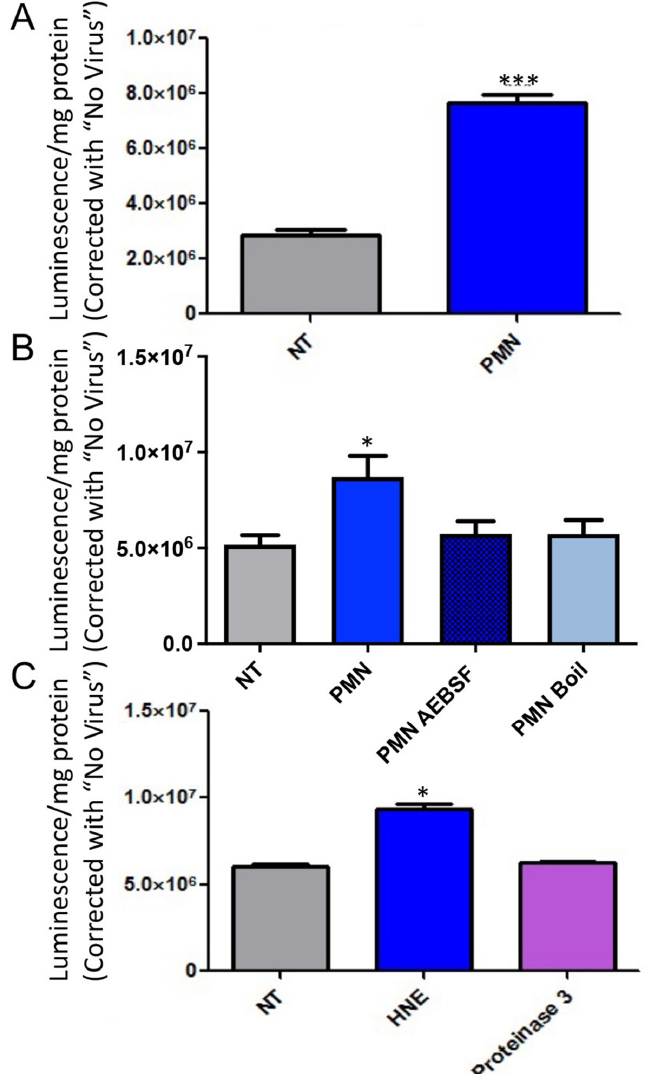
Figure 1. Exposure to primary human neutrophils leads to increased AdV5 transduction, inhibition of neutrophil serine proteases ablates PMN mediated enhancement of epithelial AdV5 transduction, and addition of human neutrophil elastase alone enhances AdV5 transduction of MDCK-CAR Ex8 epithelia. ( A ) MDCK-CAR Ex8 epithelia were induced with doxycycline and 24 h later exposed to PMN. Cells were infected with AdV-LacZ, and beta galactosidase assay was performed the following day to measure AdV transduction. Data are presented as means ± standard errors (SEM) from quadruplicate samples in 13 independent experiments. *** p < 0.001 in two tailed Students t -test. ( B ) Freshly isolated PMN were treated with serine protease inhibitor AEBSF or vehicle control in HBSS at 37 ◦ C or heat killed by placing in a boiling water bath for 30 min. Confluent monolayers of MDCK-CAR Ex8 epithelia in 24-well plates were then exposed to these PMN before infection with AdV5-LacZ and performing beta galactosidase assay the following day. ( C ) Confluent monolayers of MDCK-CAR Ex8 epithelia in 24-well plates were exposed to human neutrophil elastase, neutrophil proteinase 3, or vehicle control before infection with AdV5-LacZ and subsequent beta galactosidase assay. Error bars represent SEM of 3 independent experiments, each performed in quadruplicate. * p < 0.05 by one-way ANOVA and Bonferroni post-hoc test. NT, non-treated; all other treatments were compared to